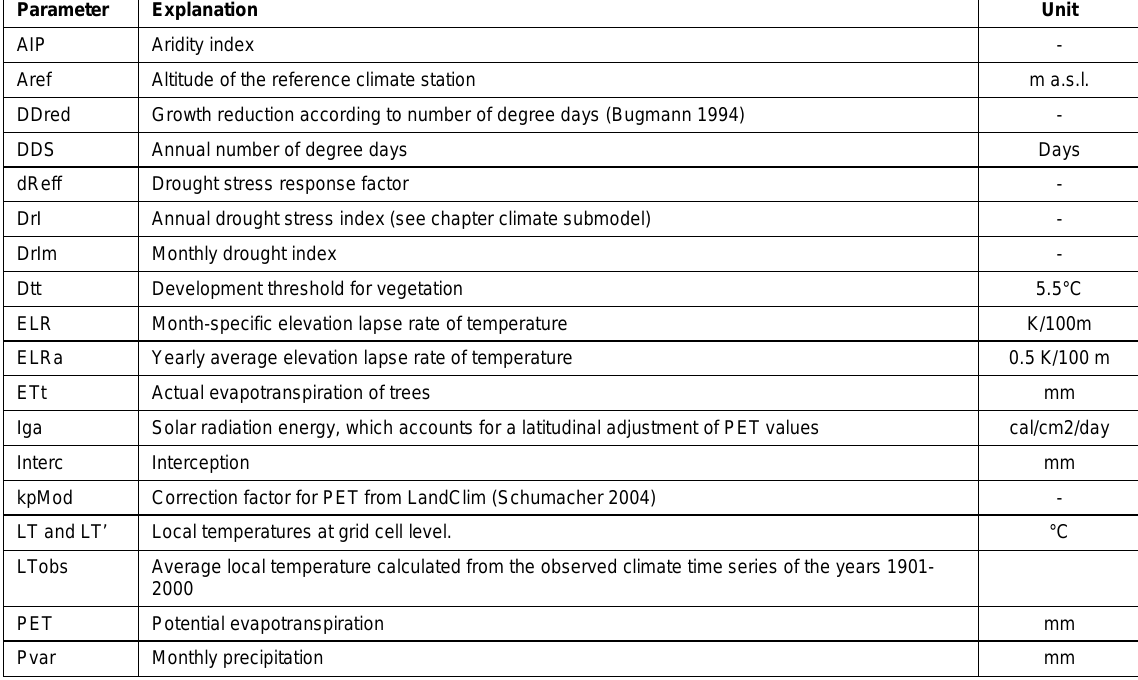
Table A2: Parameters of WoodPaM, which have been newly introduced since Gillet (2008) and which are not given in Table A1. Parameters are listed in alphabetical